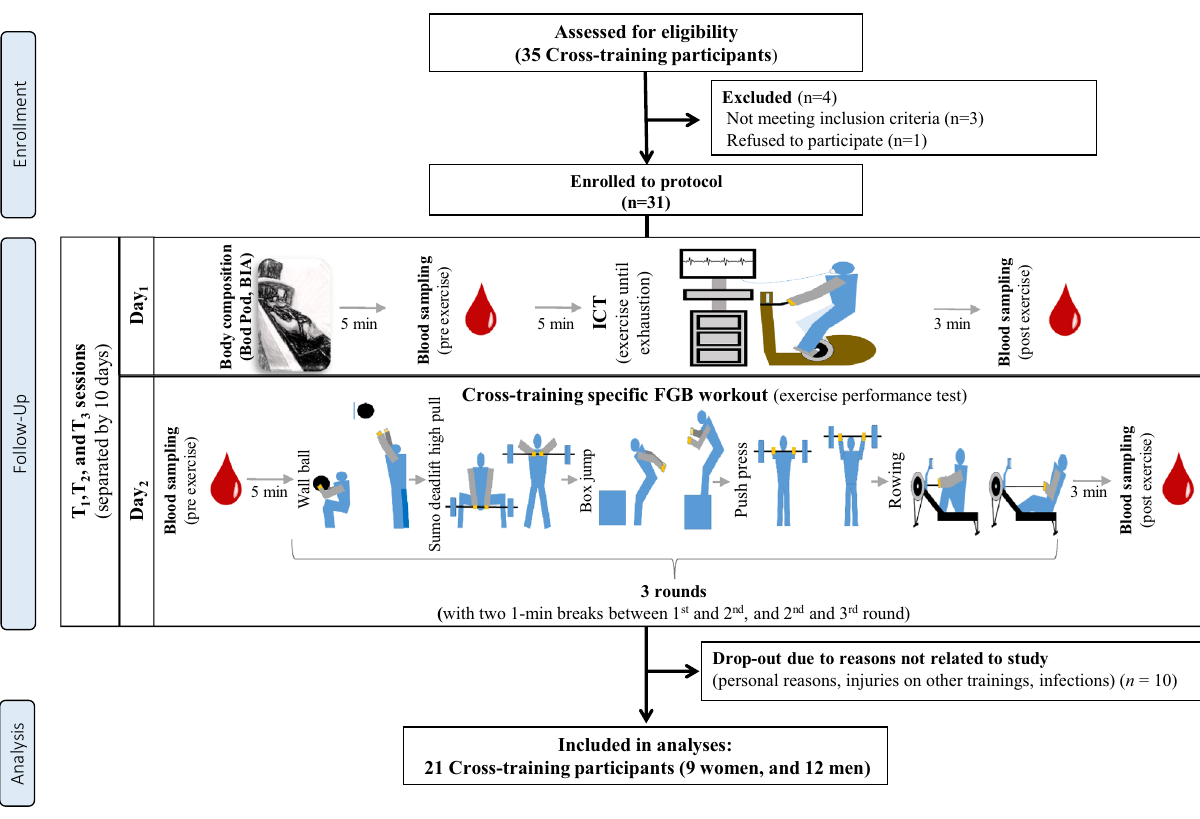
Figure 2. A flow chart of the study